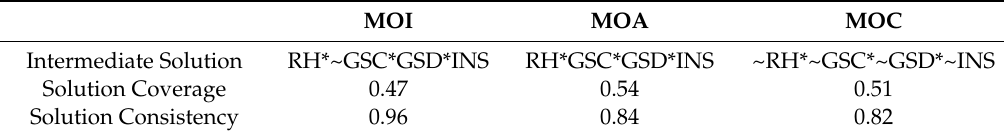
Table 9. Di ff erent paths of IHC organizational modes (1).